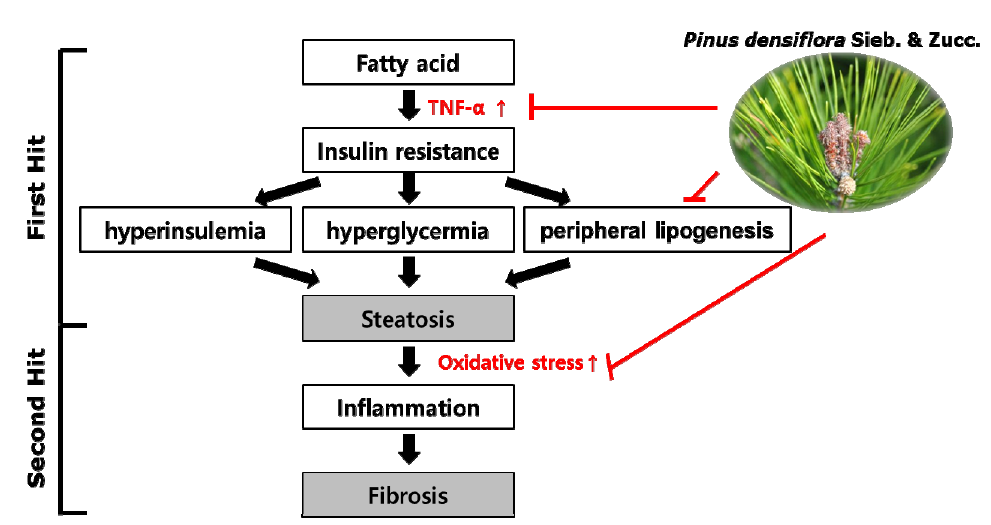
Figure 8. Proposed model for the inhibition of steatosis by Pinus densiflora Sieb. et Zucc. (PSZ) extracts in HepG2 cells. PSZ decreases TNF production, hepatic lipogenesis and oxidative stress, resulting in the improvement of hepatic